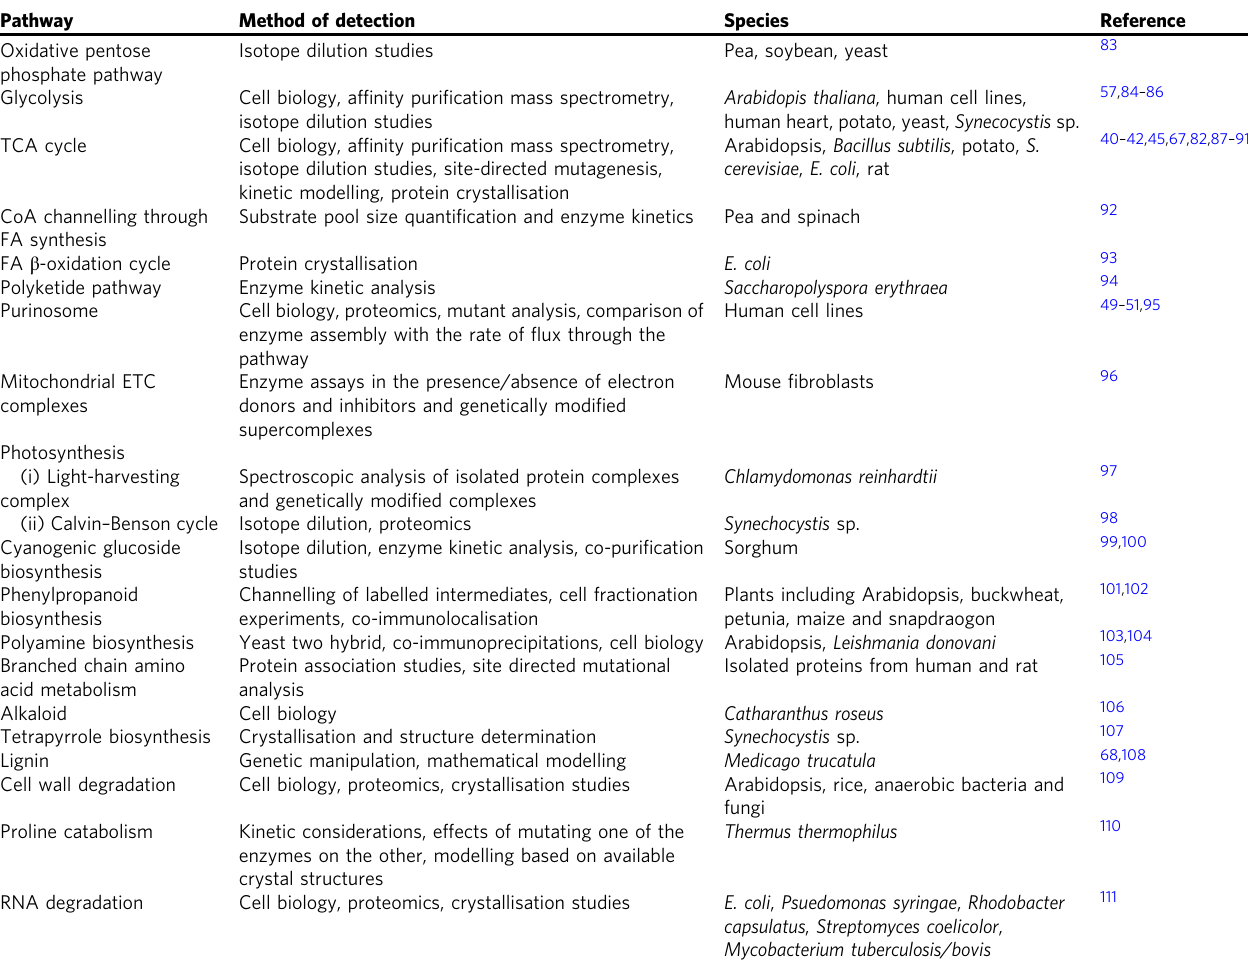
Table 1 A representative list of dynamic enzyme assemblies, the species in which, and the method(s) by which, they were